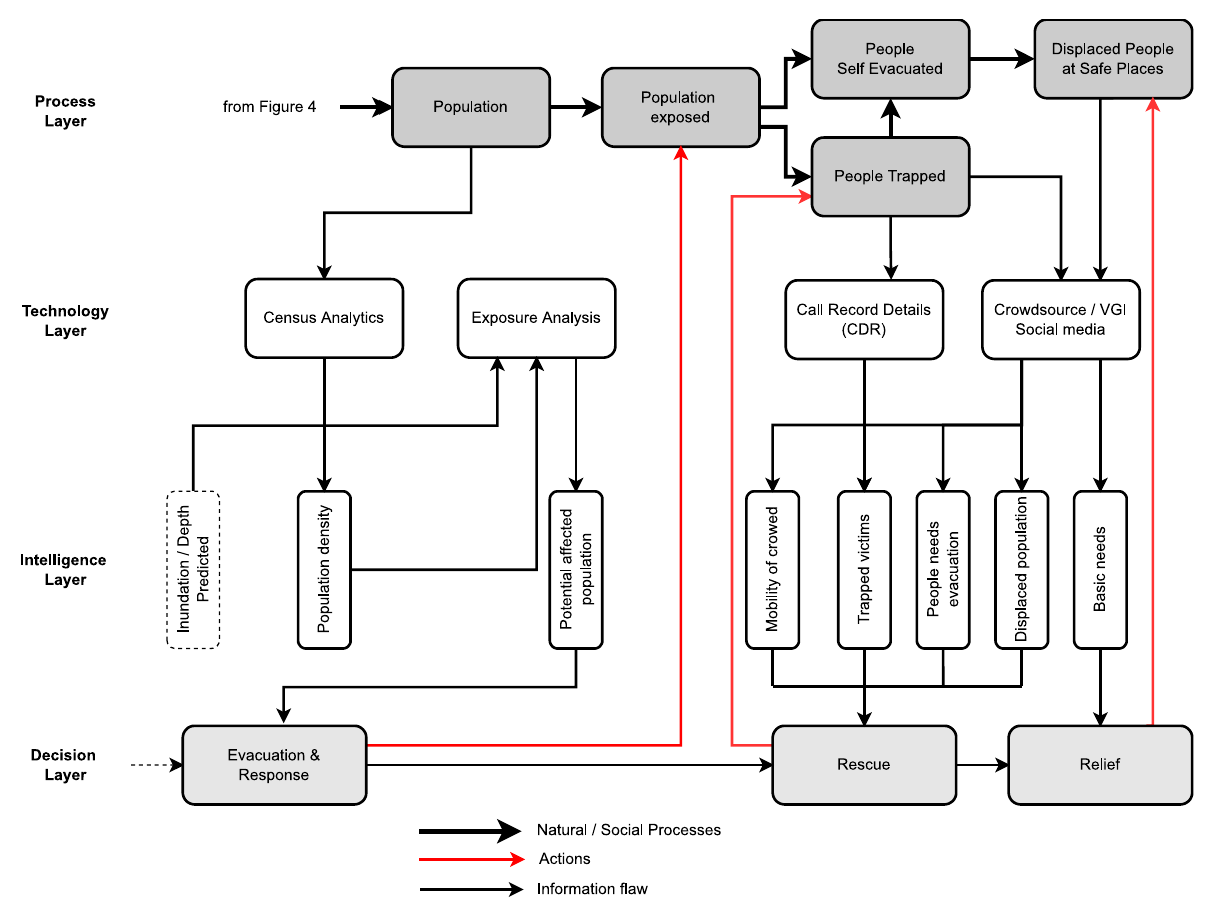
Figure 5. Intelligence required for issuing early warnings, rescue, and relief operations.